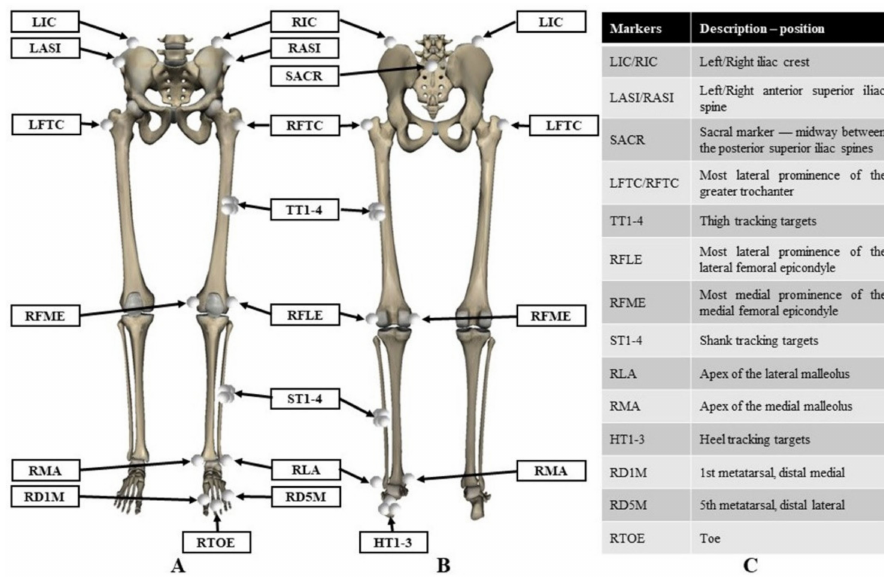
Figure 1. Illustration of reflective markers attached to the lower limbs. ( A ) Front view; ( B ) rear view; ( C ) marker